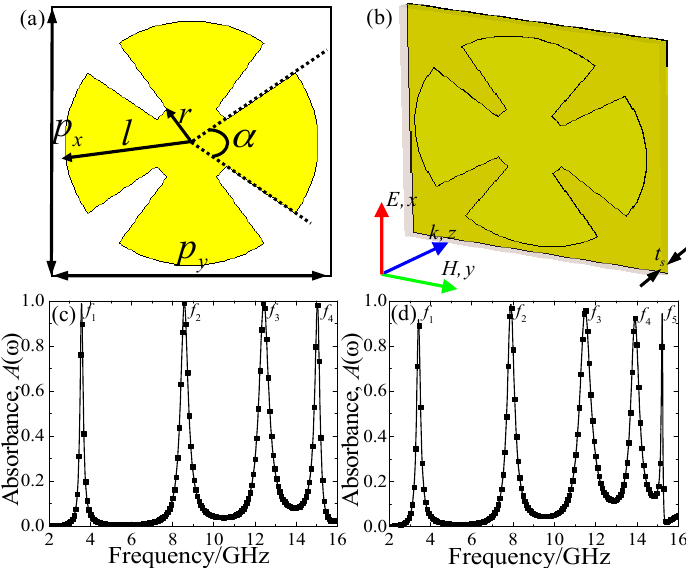
Figure 6. The ( a ) front view and ( b ) perspective view of the unit-cell structure of the designed MMA; with the simulated absorbance for the ( c ) four- and ( d ) five-band MMAs.